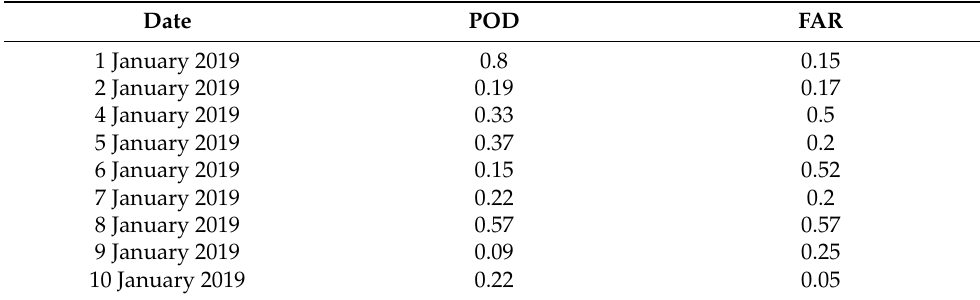
Table 3. POD and FAR score for days with fronts in January